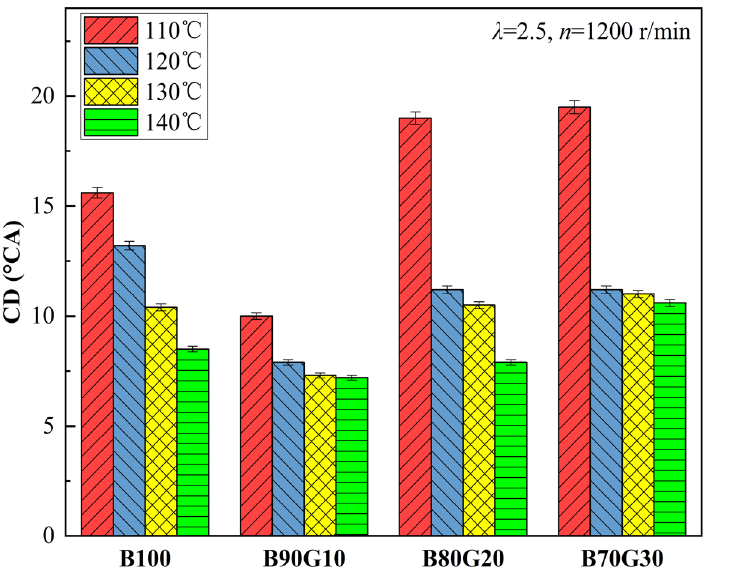
Figure 15. CD with different T in